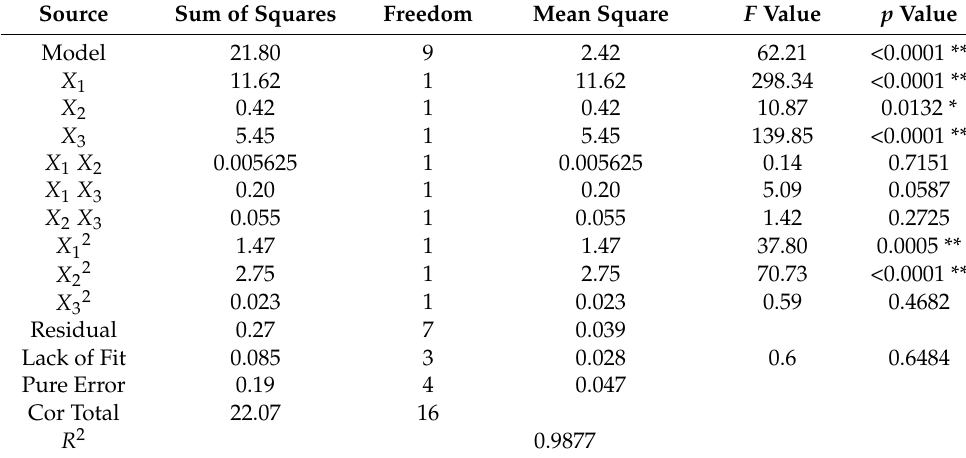
Table 4. The analysis of variance (ANOVA) on the collision impact